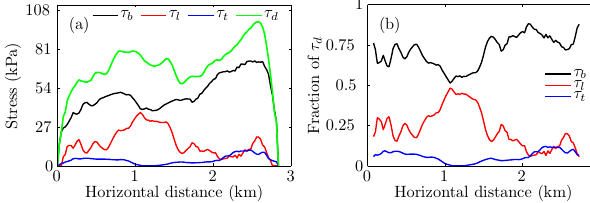
Fig. 7. Driving stress and flow resistances in the present-day Haig Glacier. (a) Longitudinal profiles of resistances, such that τ d = τ b + τ l + τ t . (b) Fractional contribution of resistances to driving